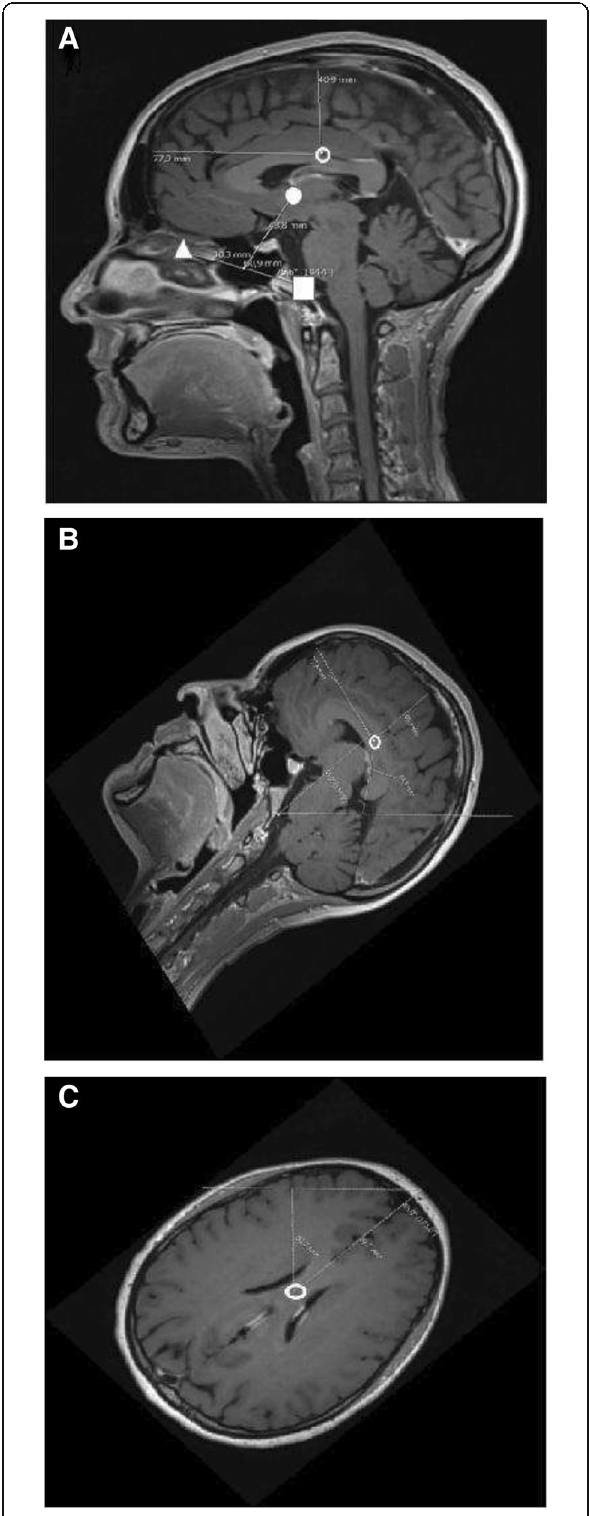
Fig. 1 (abstract 0232). Symbols: ○ midpoint; ■ meatus; • Monroe; ▲